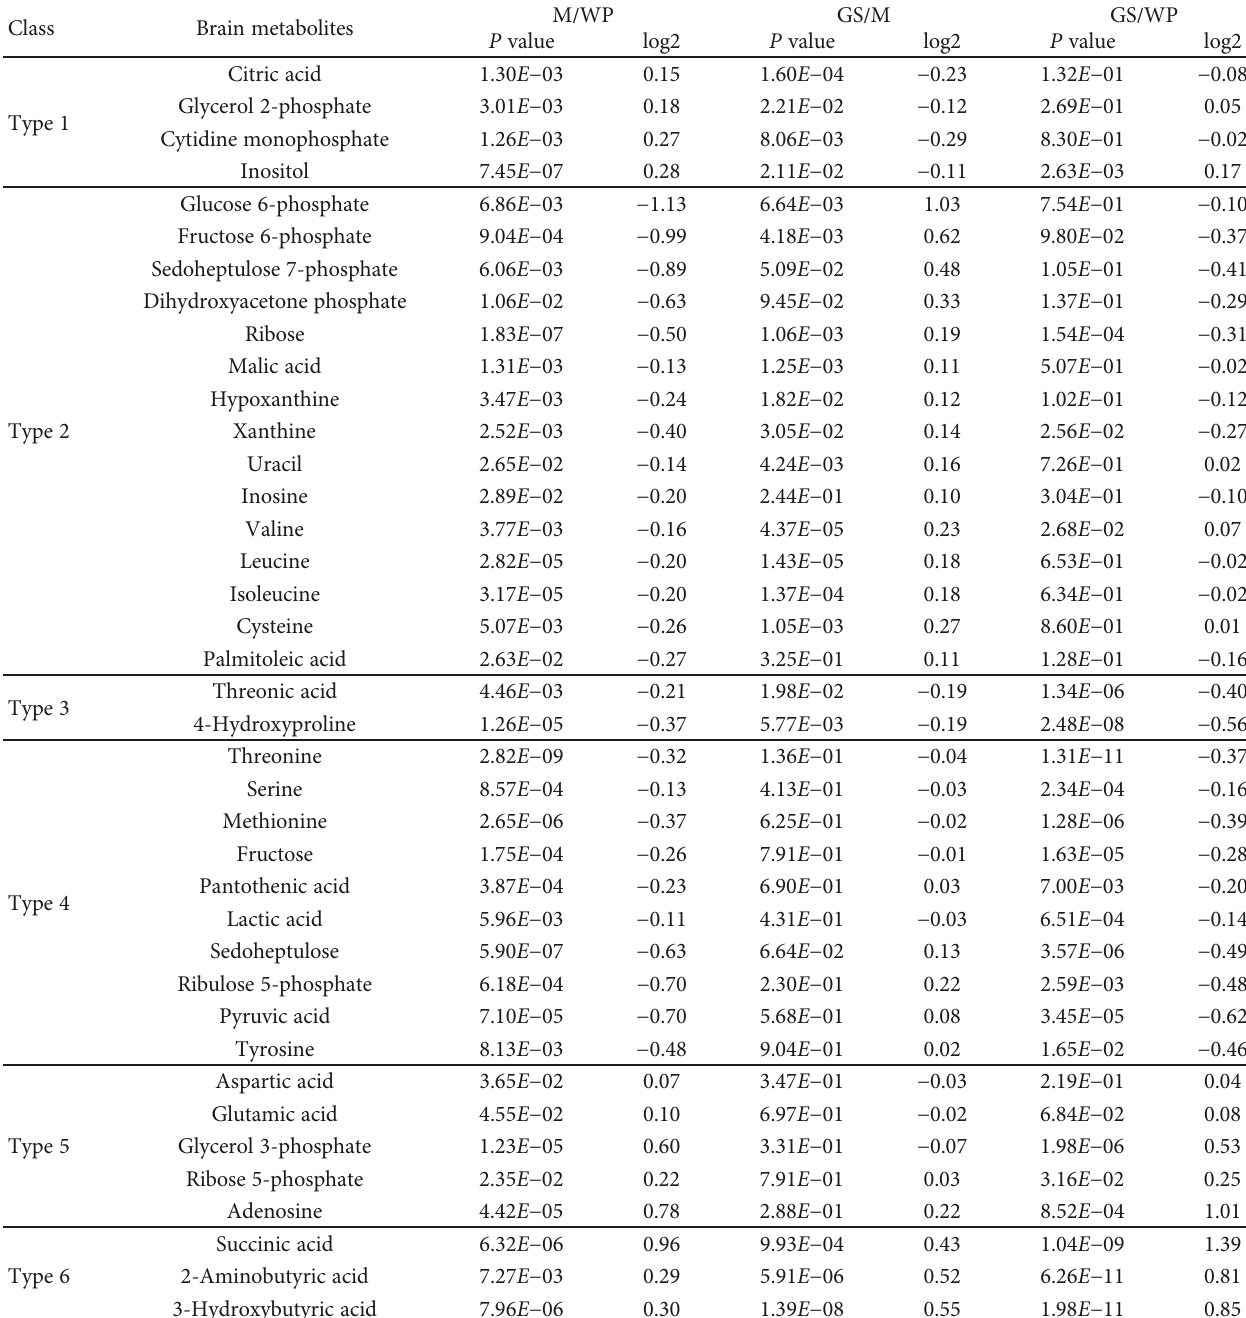
Table 4: Di ff erential expressed cerebral